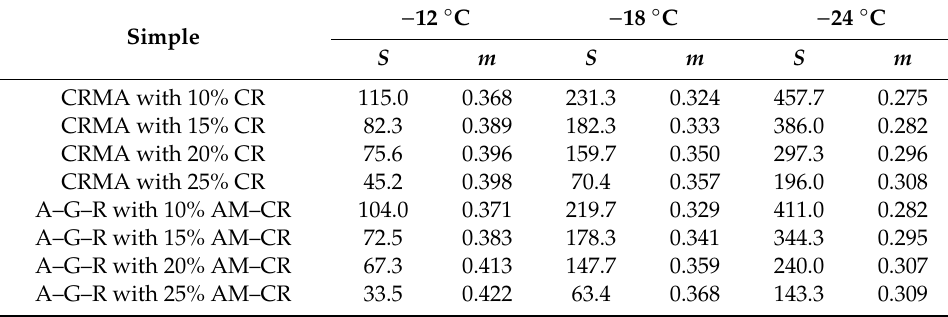
Table 3. Creep sti ff ness modulus S and creep rate m value of CRMA and A–G–R.